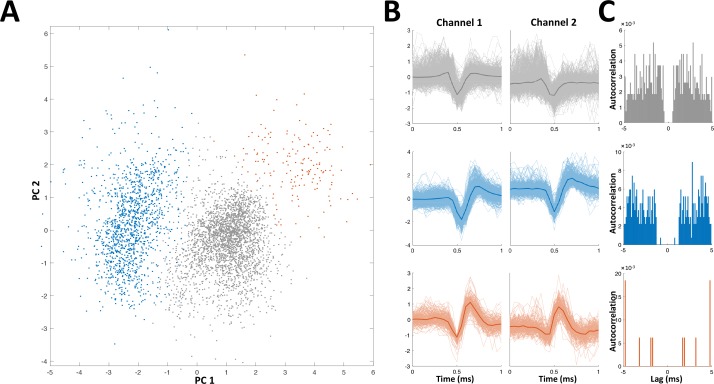
Spike sorting example.Recordings were made using either stereotrodes (two wire bundles) or tritrodes (three wire bundles); one wire was used as reference, so that near perfect cancelation of the electric organ discharge (EOD) interference was obtained. Recordings therefore consisted of either one or two channels. In the depicted example two channels (i.e., a tritrode) were employed. (A) Distribution of first two principal components of detected spikes, color coded according to unit identity (grey- multi-unit, blue and red- single units). (B) Spike shapes in the two recording channels for each unit (color codes as in panel A). (C) Autocorrelations of spiking activity in the three units. Single units (blue and red) are characterized by a refractory period (larger than the refractory period set for the spike detection algorithm, 1 ms).